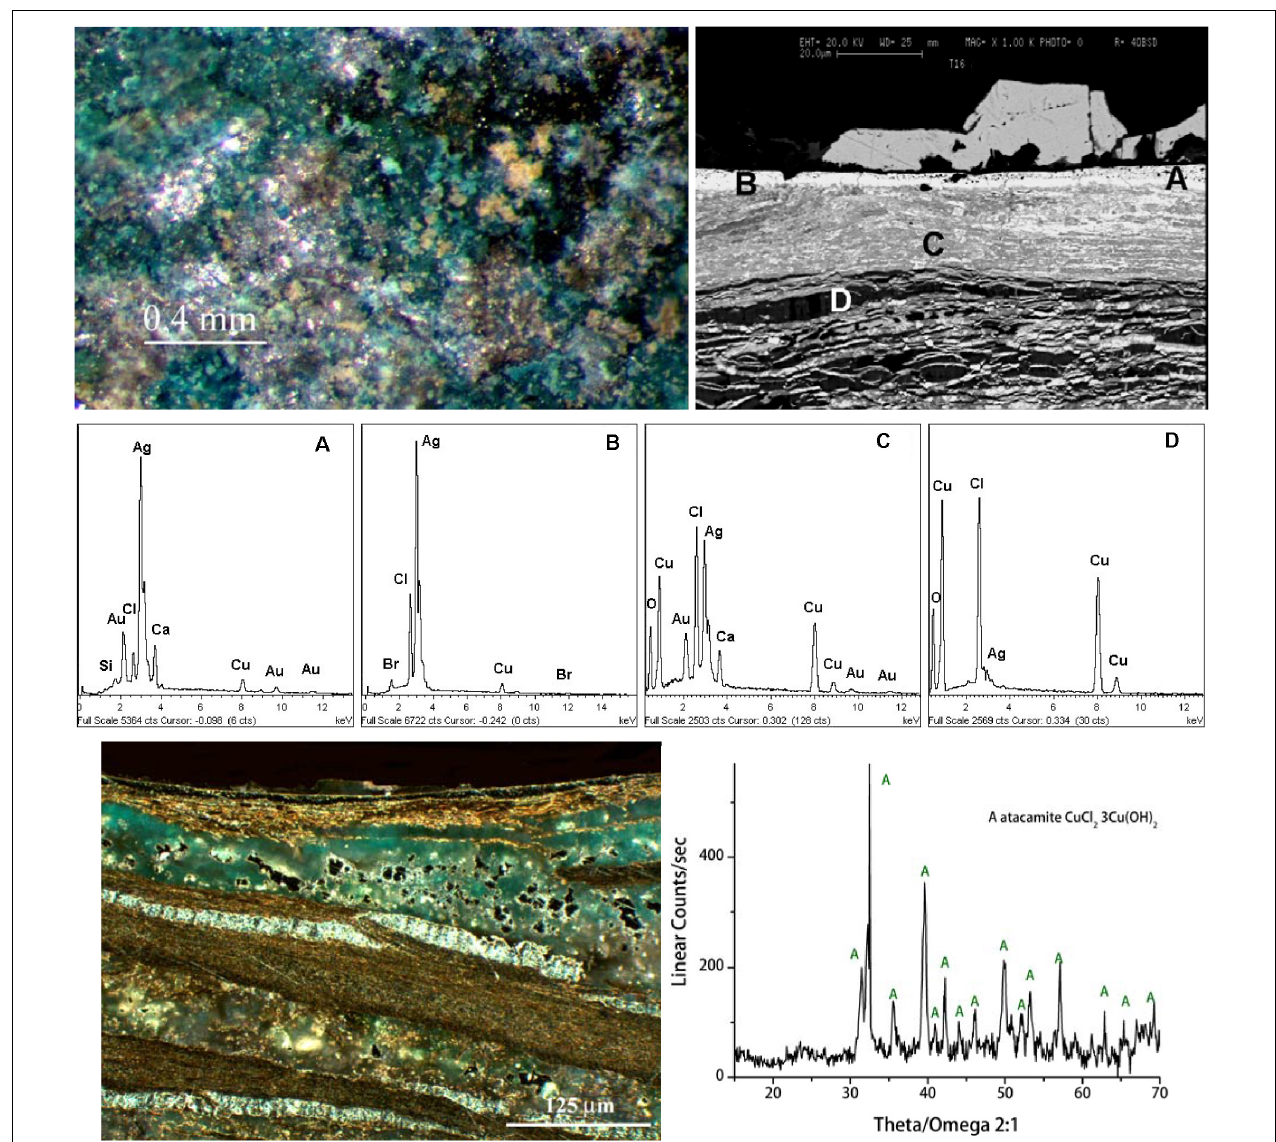
FIGURE 3 | SEM and OM images and EDS spectra (A–D) of a fragment of a silver plated nariguera almost completely mineralized found in the tomb T16 of the warrior with a ceremonial trumpet called Pututo. The results describe the micro-chemical structure of the surface silver-enriched layer as well as show the internal corroded structure of the artifact. The XRD pattern of the green copper corrosion product (third row) reveals the presence of harmful atacamite that is present also inside the artefact (see the OM image shown in the third row).